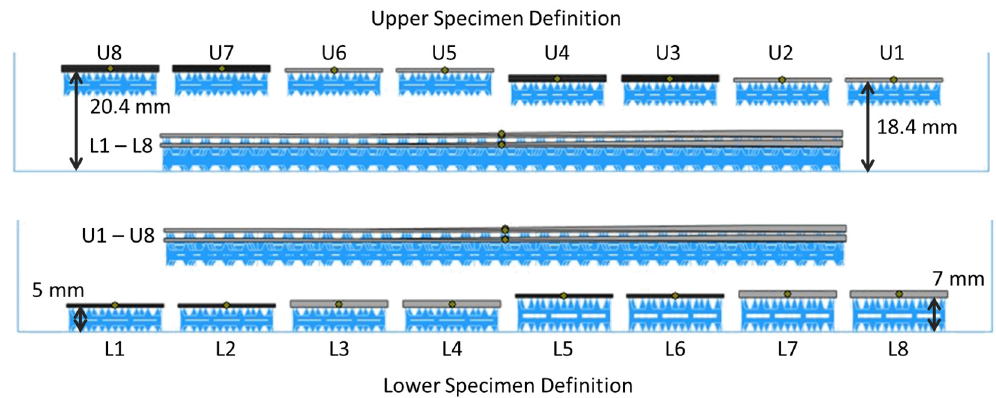
Figure 3. Meso-scale experimental design showing the side views of the build volume with specimen labels and build height dimensions of the upper and lower specimen sets. The experimental specimens are colored gray, while support features are shown in blue.